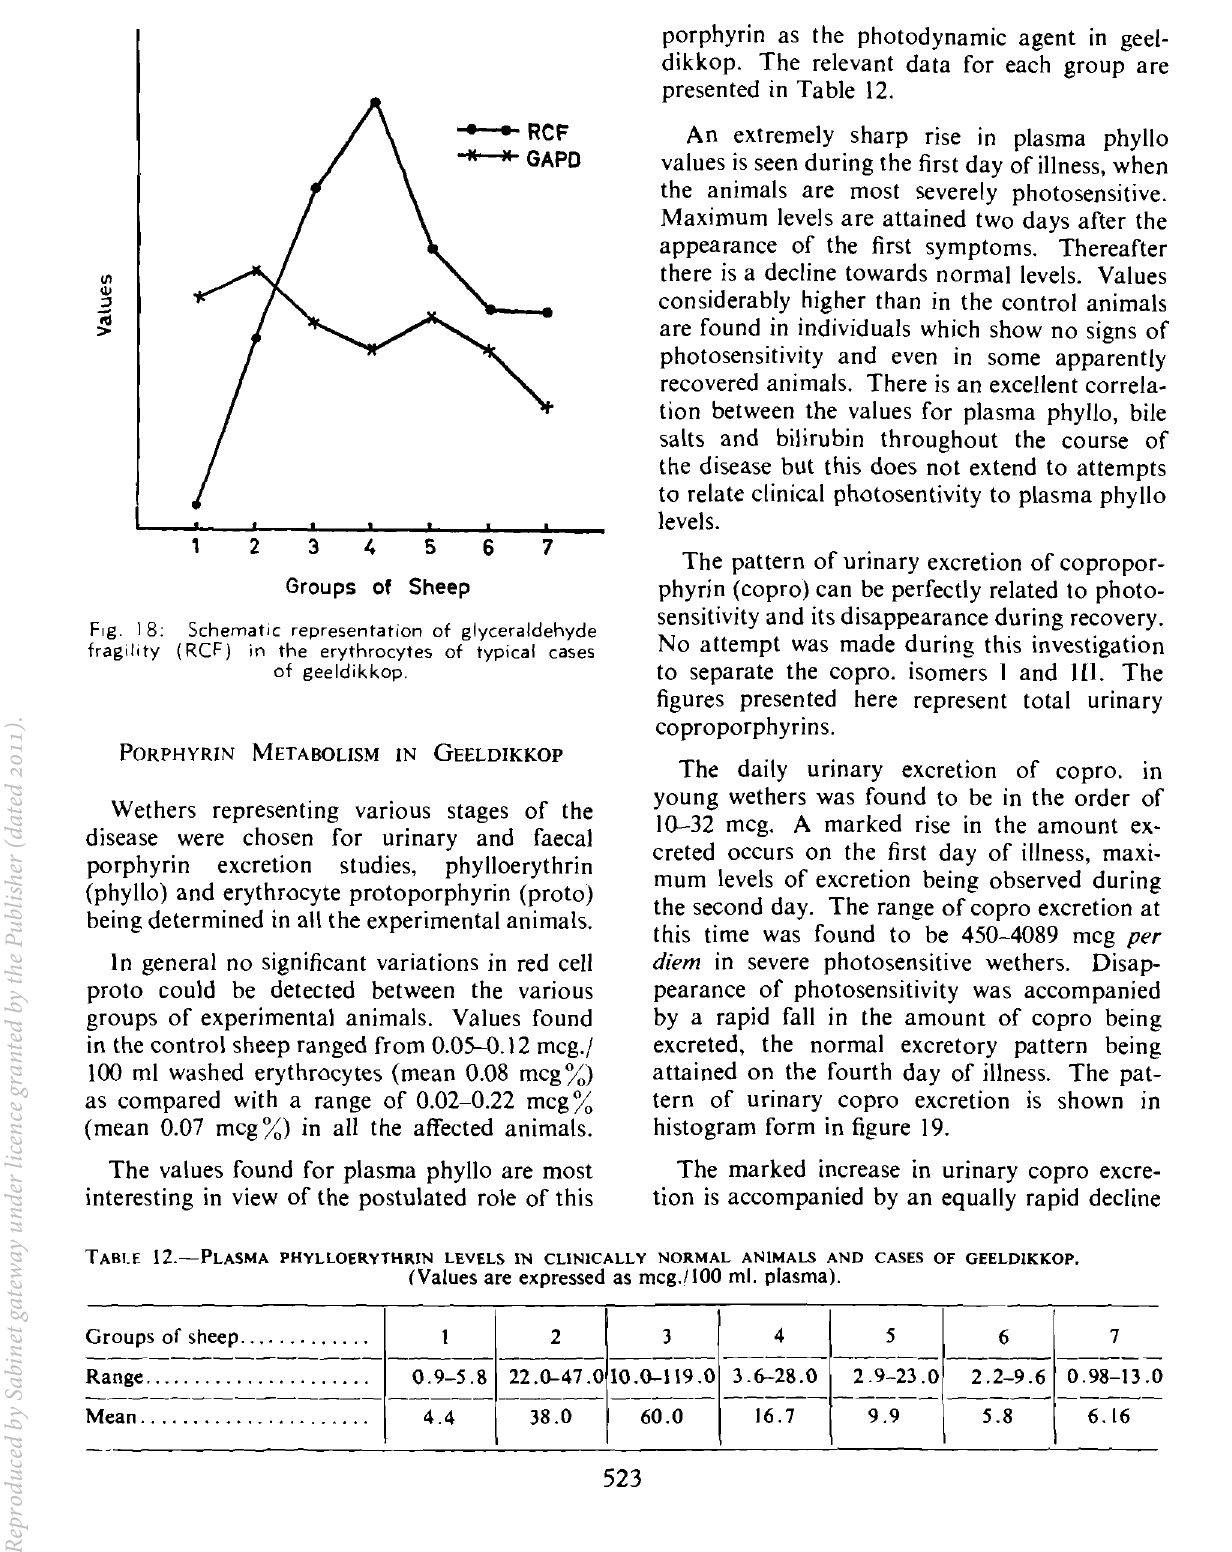
TABLE 12.-PLASMA PHYLLOERYTHRIN LEVELS IN CLINICALLY NORMAL ANIMALS AND CASES OF GEELDIKKOP. (Values are expressed as mcg.llOO ml.